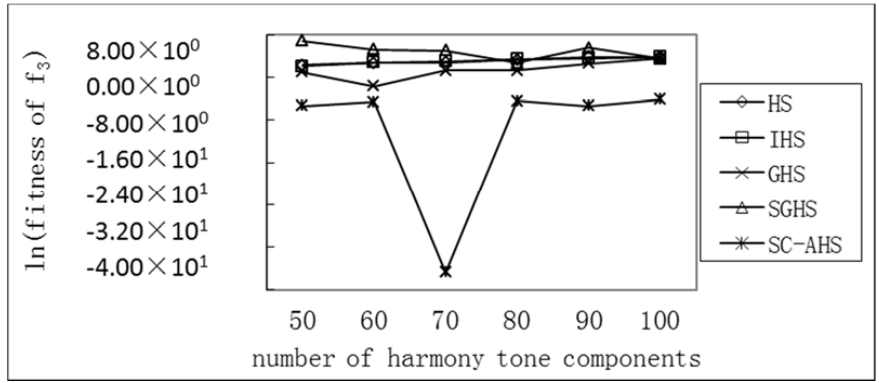
Figure 4. Comparison of the average optimum with different harmony tone components of the Griewank function.